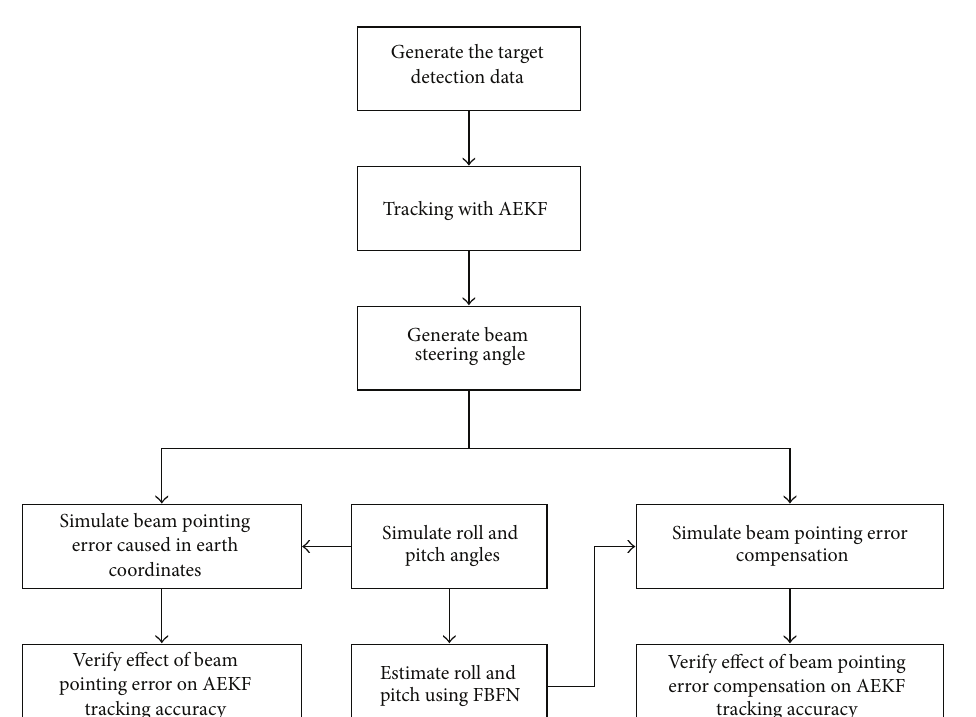
Figure 17: Flow chart of simulation used to verify the effect of beam pointing error compensation on AEKF tracking